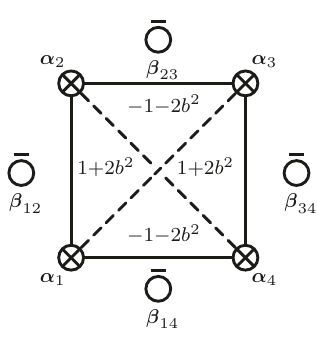
Figure 1 . Screening charges corresponding to the deformed O (3) sigma